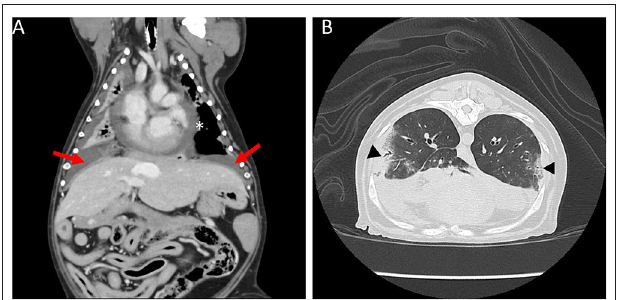
FIGURE 1 | Coronal and sagittal computed tomography (CT) images of the thorax. (A) Moderate bilateral pleural effusion (arrows) and moderate pericardial effusion (asterisk). (B) Multifocal mixed unstructured interstitial to coalescing alveolar pulmonary pattern (triangles).